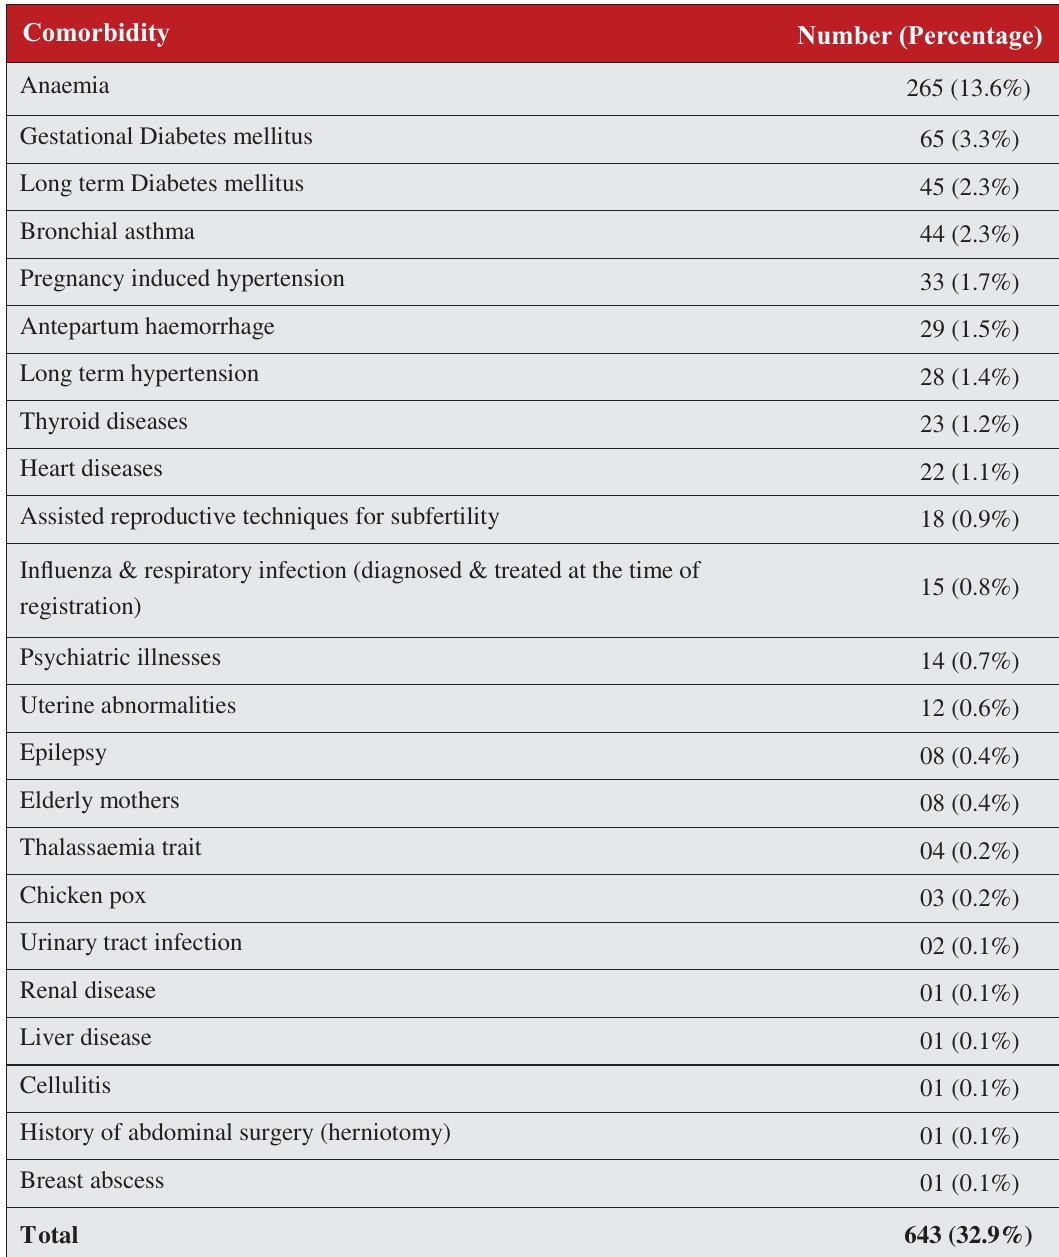
Table: 1 Distribution of co-morbidities among registered mothers of 32 weeks and above